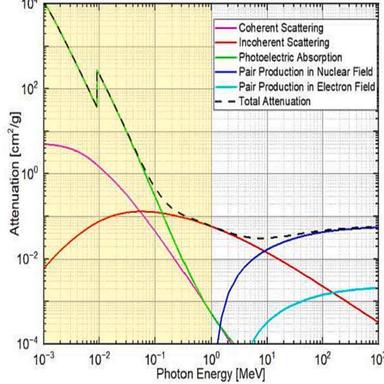
Theoretical photon mass attenuation coefficient μ/ρ (black dashed line) and the partial attenuations of copper as a function of the radiation energy. The yellow highlighted area marks the effects E < 1 MeV. This data is imported from NIST .